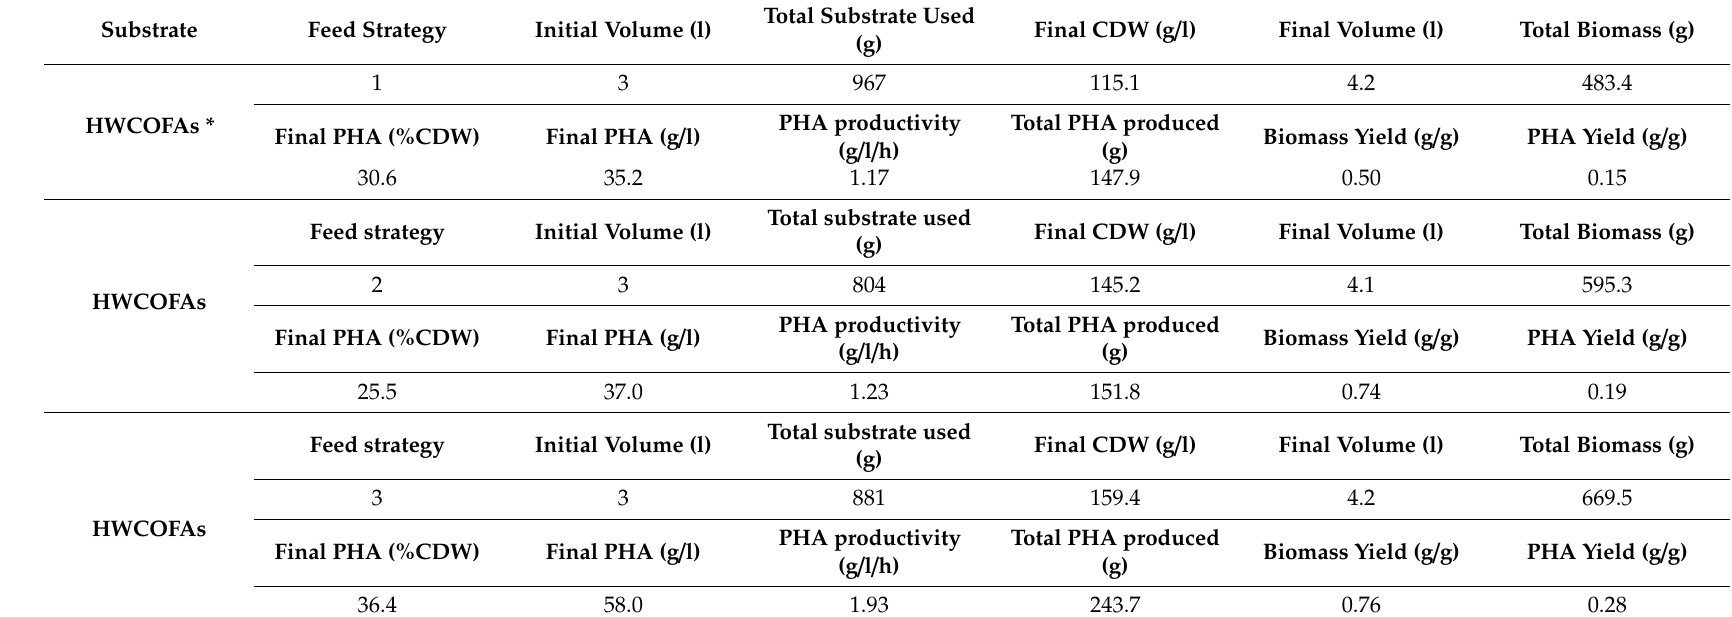
Table 1. Growth data for P. putida KT2440 using di ff erent feeding